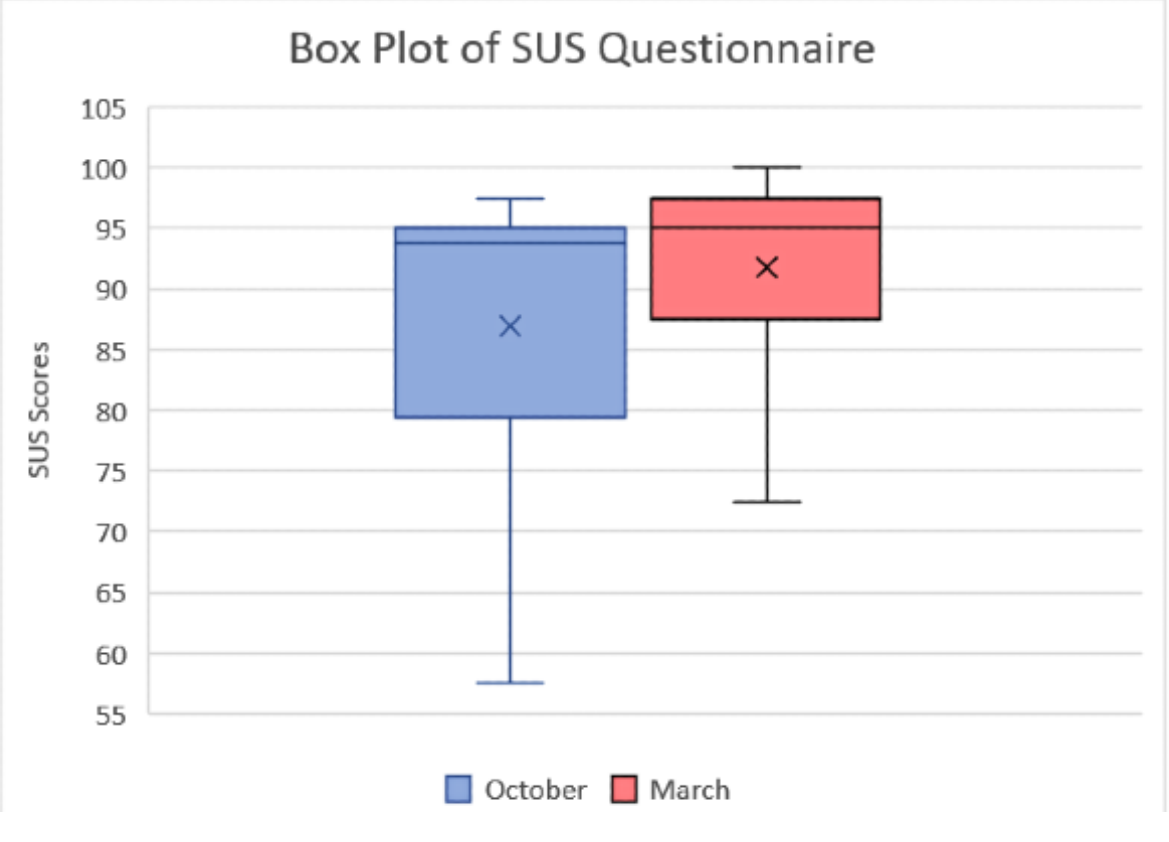
Figure 12. Box plot of SUS scores of the educators from the first (October) and second (March) sessions. SUS: System Usability